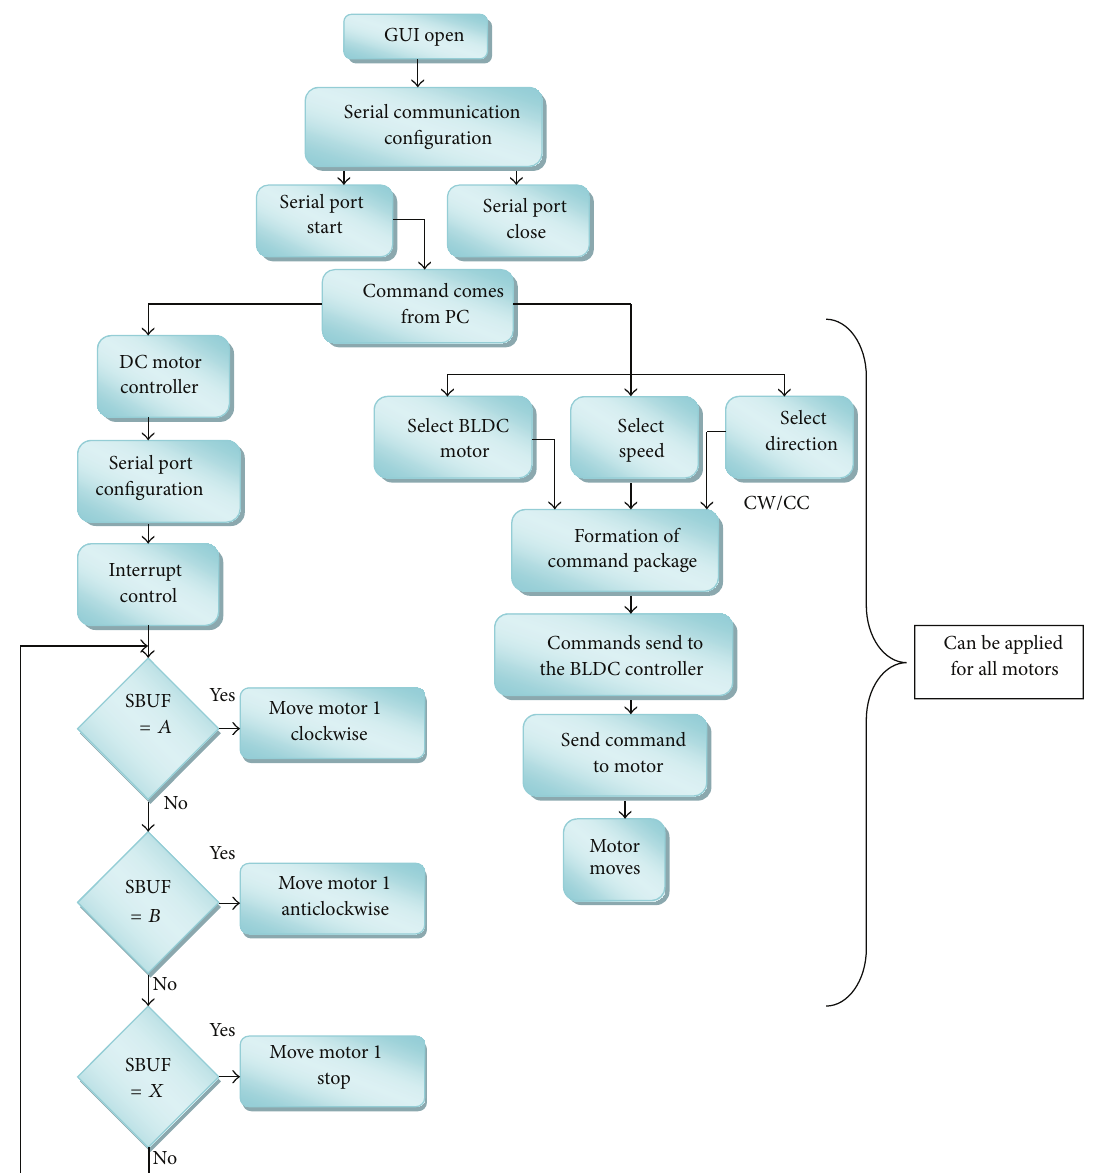
Figure 18: Flow chart for PC based